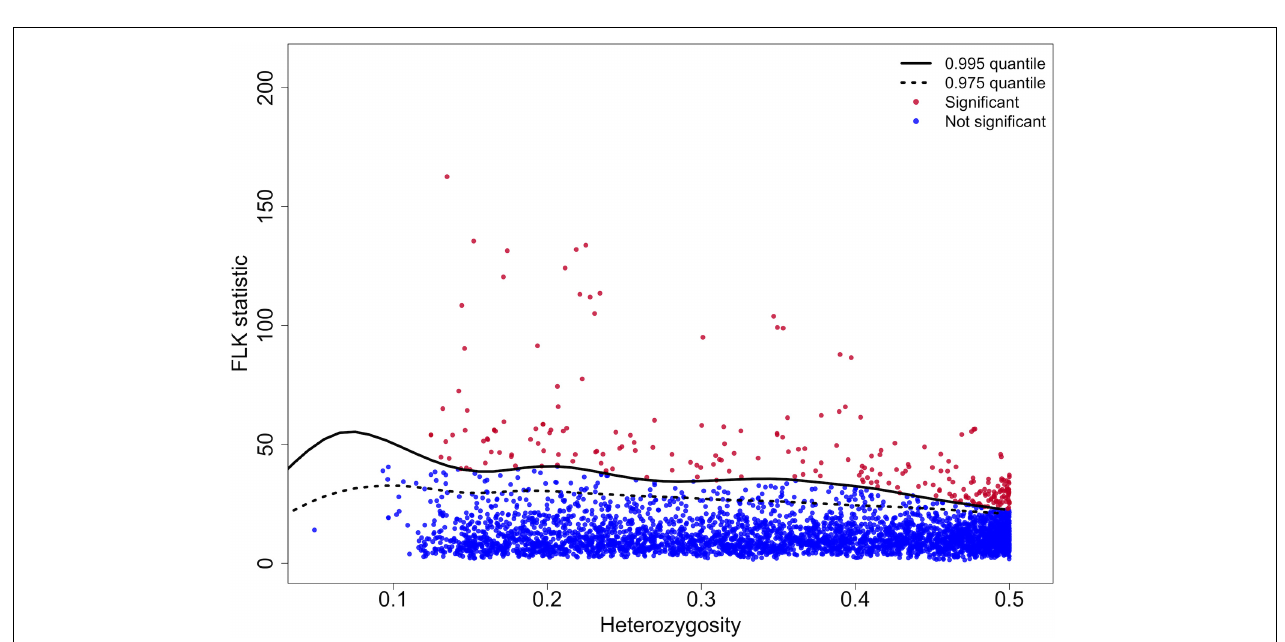
FIGURE 5 | Mantel tests for correlation between genetic distance (y-axis) and geographic distance in kilometers (x-axis) in the Gulf of Maine and Southern New England. Regression lines are drawn for the Gulf of Maine (blue) and Southern New England (red).